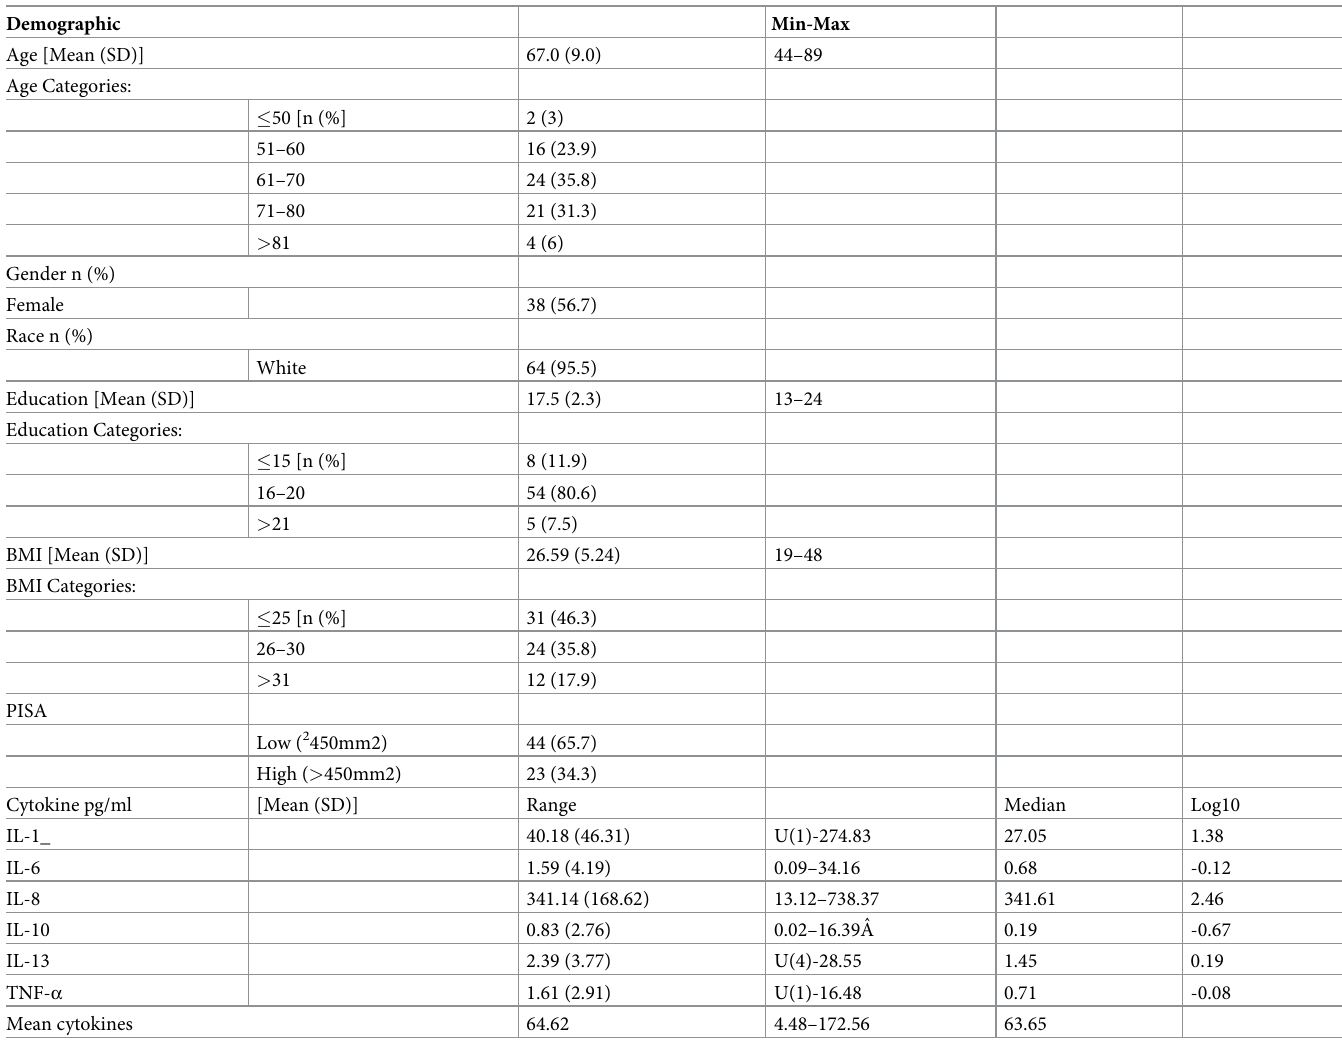
Table 1. Characteristics of the study population (n =